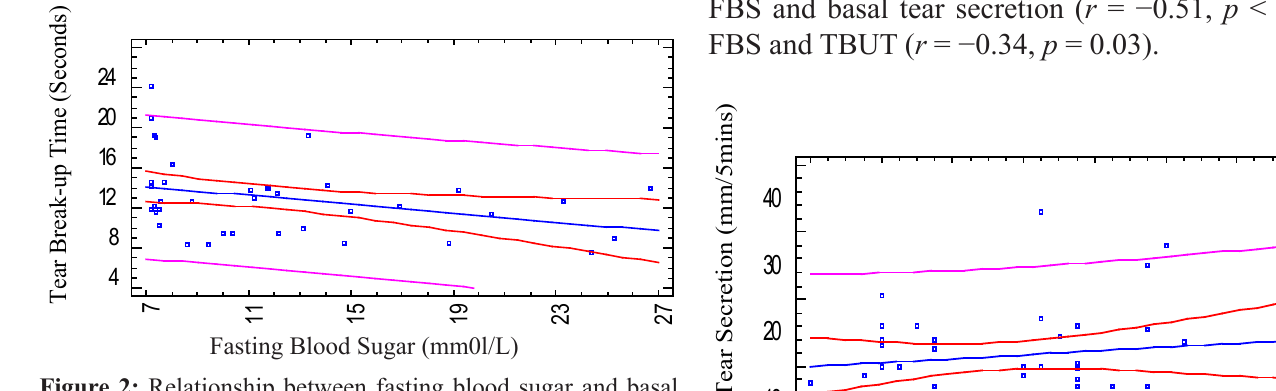
Figure 2: Relationship between fasting blood sugar and basal tear secretion in the NIDDM group.